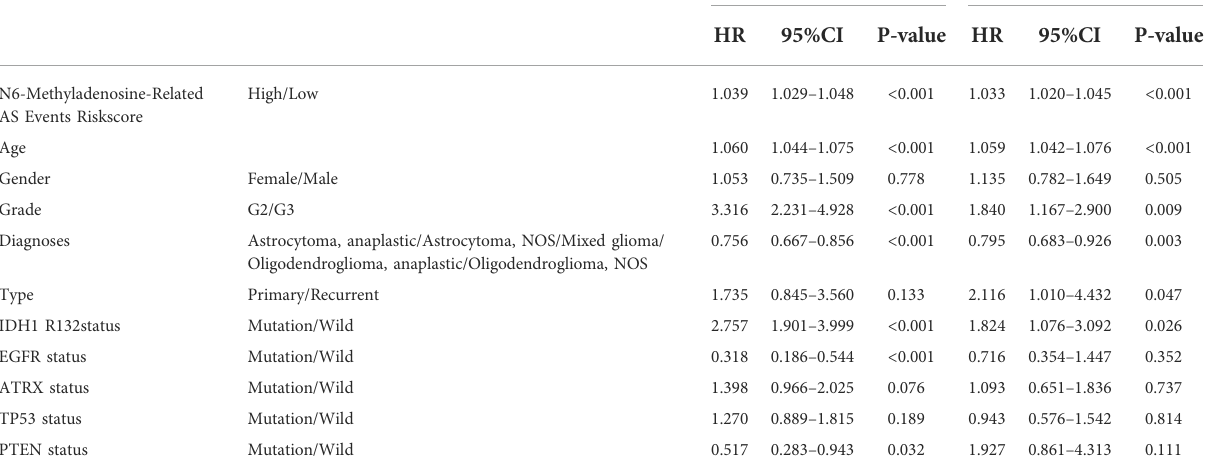
TABLE3UnivariateandMultivariateCoxProportional-HazardsanalysisfortheN6-Methyladenosine-RelatedASEventsRiskscoreandoverallsurvival in LGG patient cohorts.